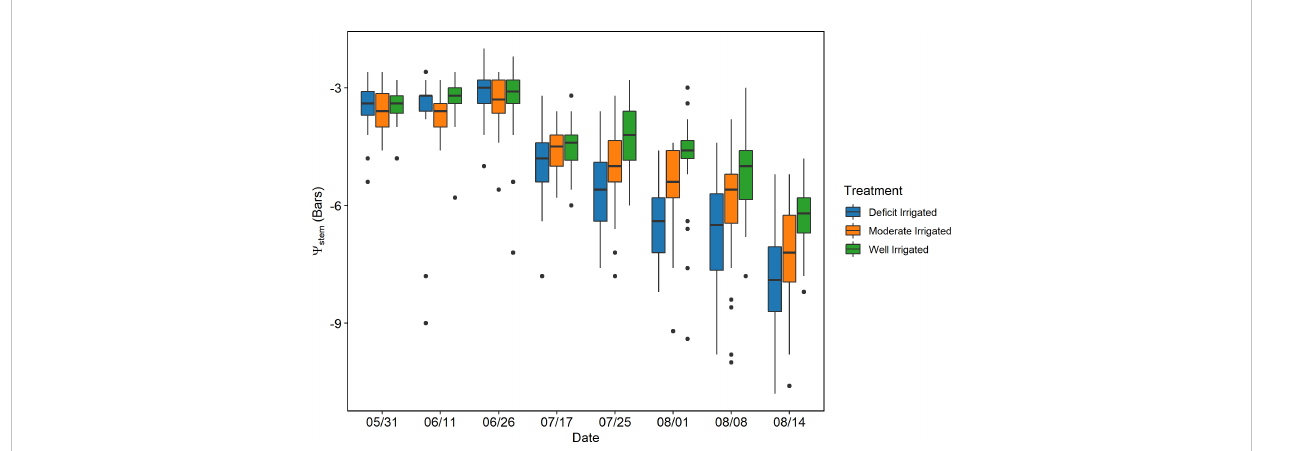
FIGURE 4 The seasonal change of the stem water potential ( y stem) in the plots where the proximal sensors were located. The red frames represent the dates when the unmanned aerial vehicles imageries were